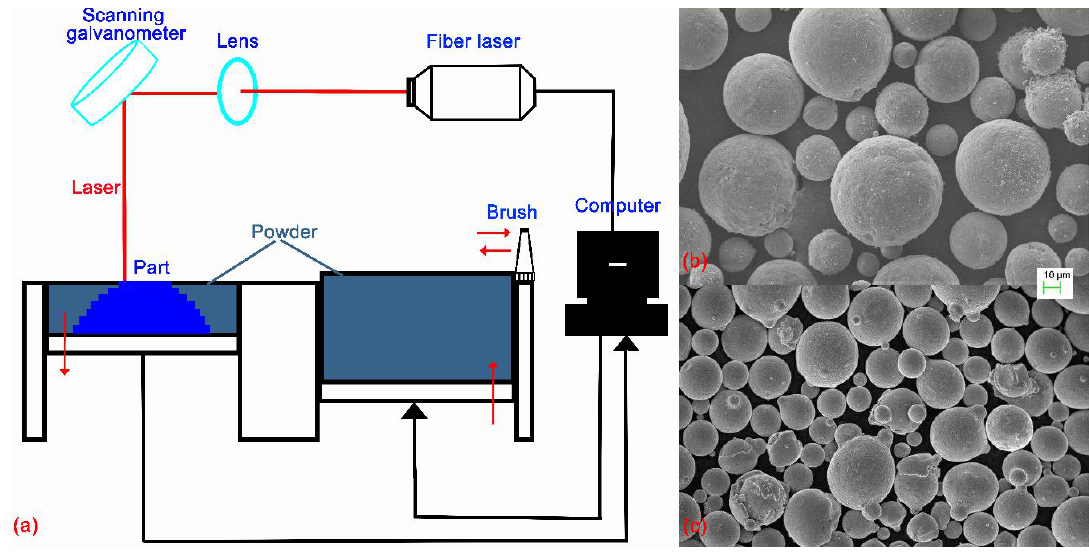
Figure 1. ( a ) The principle of L-PBF process; ( b ) The micromorphology images of 316LSS powder; ( c ) The micromorphology images of IN718 powder.